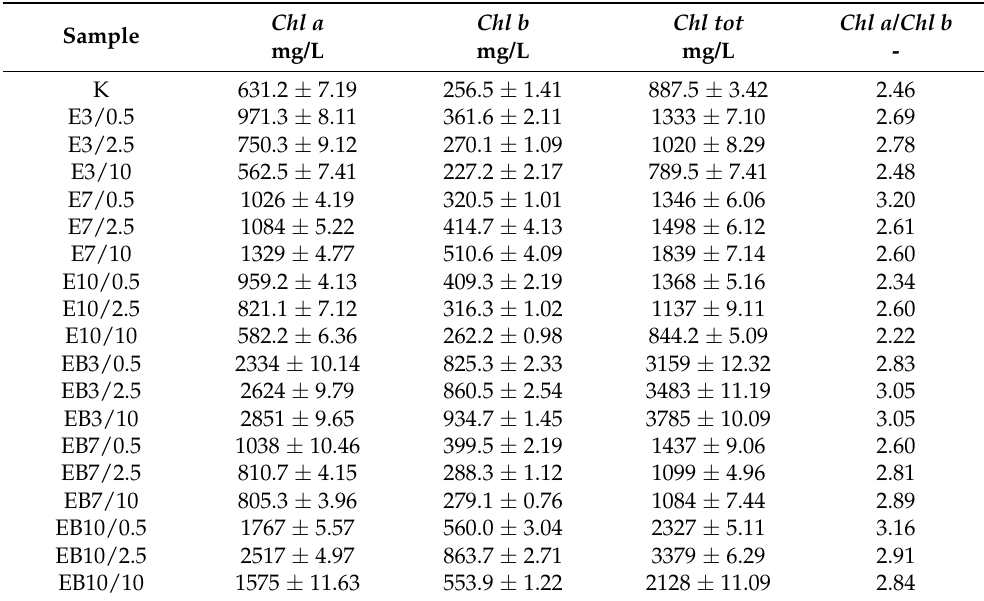
Table 3. Evaluation of chlorophyll content in the tested wheat treated with fungal extracts. C—control, E3—group treated with the aqueous extract obtained at 25 ◦ C pH = 3, E7—group treated with the aqueous extract obtained at 25 ◦ C pH = 7, E10—group treated with the aqueous extract obtained at 25 ◦ C pH = 10, EB3—group treated with the aqueous extract obtained at 75 ◦ C pH = 3, EB7—group treated with the aqueous extract obtained at 75 ◦ C pH = 7, EB10—group treated with the aqueous extract obtained at 75 ◦ C pH = 10. Concentrations used: 0.5—concentration